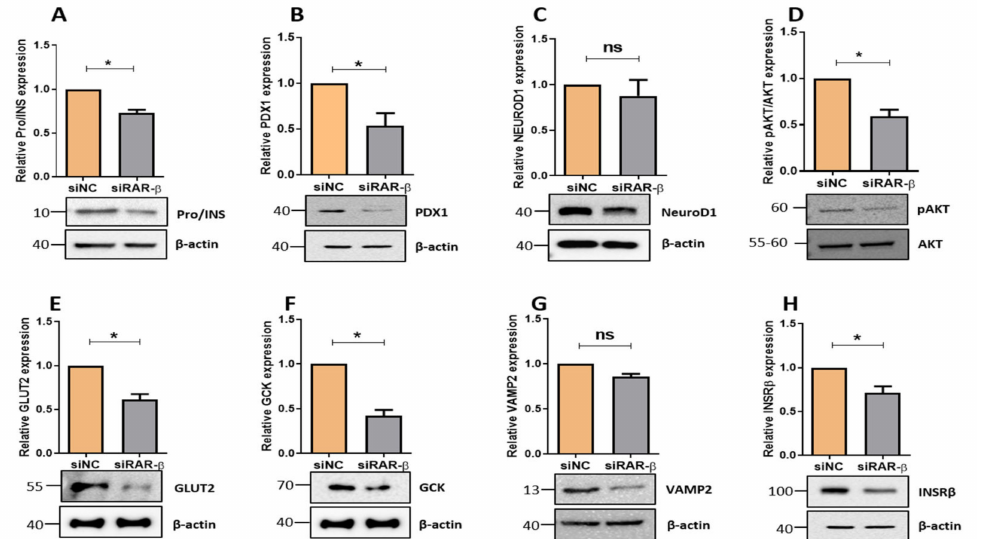
Figure 5. Impact of Rar β -silencing on β -cell function genes at protein level. Western blot analysis of Pro/insulin ( A ), PDX1 ( B ), NEUROD1 ( C ), p-AKT/AKT ( D ), GLUT2 ( E ), GCK ( F ), VAMP2 ( G ), and INS β ( H ) normalized to the endogenous control protein β -actin. Corresponding fold changes in the intensity of the Western blot are shown below each blot. Data are obtained from three independent experiments. p -value. *: p < 0.05. Error bars show mean ± SD. Full western blot figures are available in supplementary file.